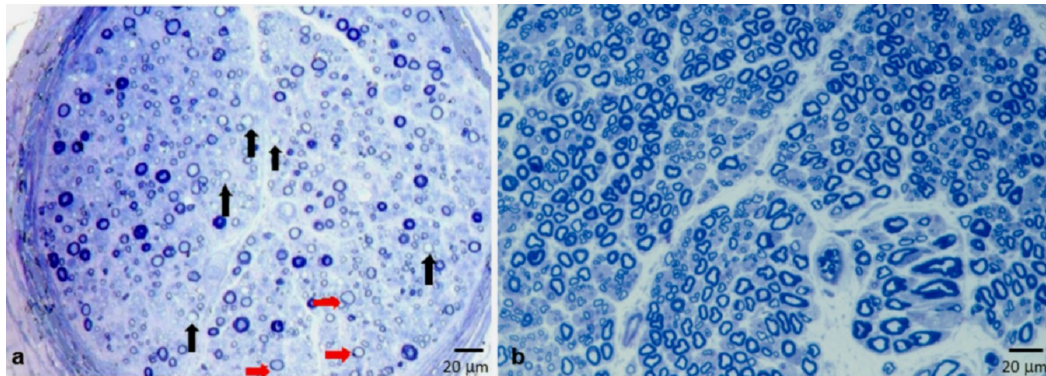
Figure 4. Semithin section stained with toluidine blue. Sural nerve biopsy performed in a 66-year-old man with “typical” CIDP ( a ), and sural nerve biopsy from a normal subject matched per age ( b ). A moderate reduction of myelinated fibers is shown (a). Many fibers (75%) have a thin myelin sheath if compared with axon diameter (red arrows in (a)); few fibers (4%) are devoid of myelin sheath (“naked axons”, black arrows in (a)).